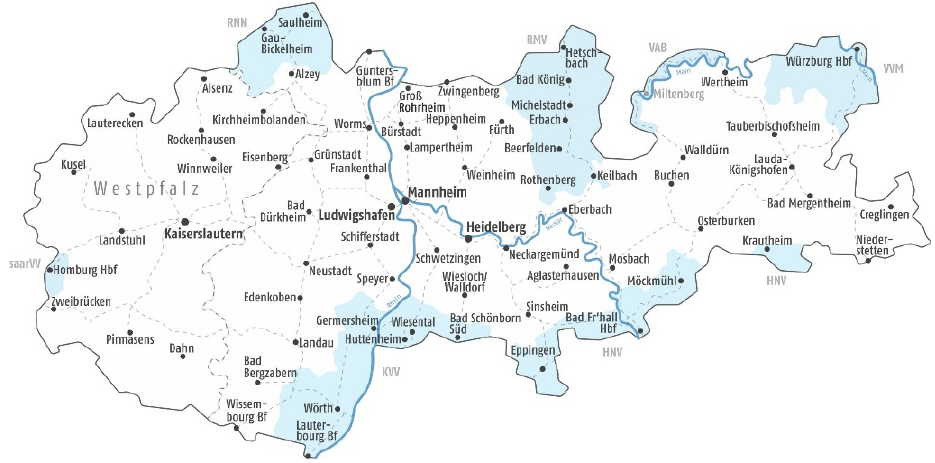
Figure 1. The supply area of VRNnextbike.